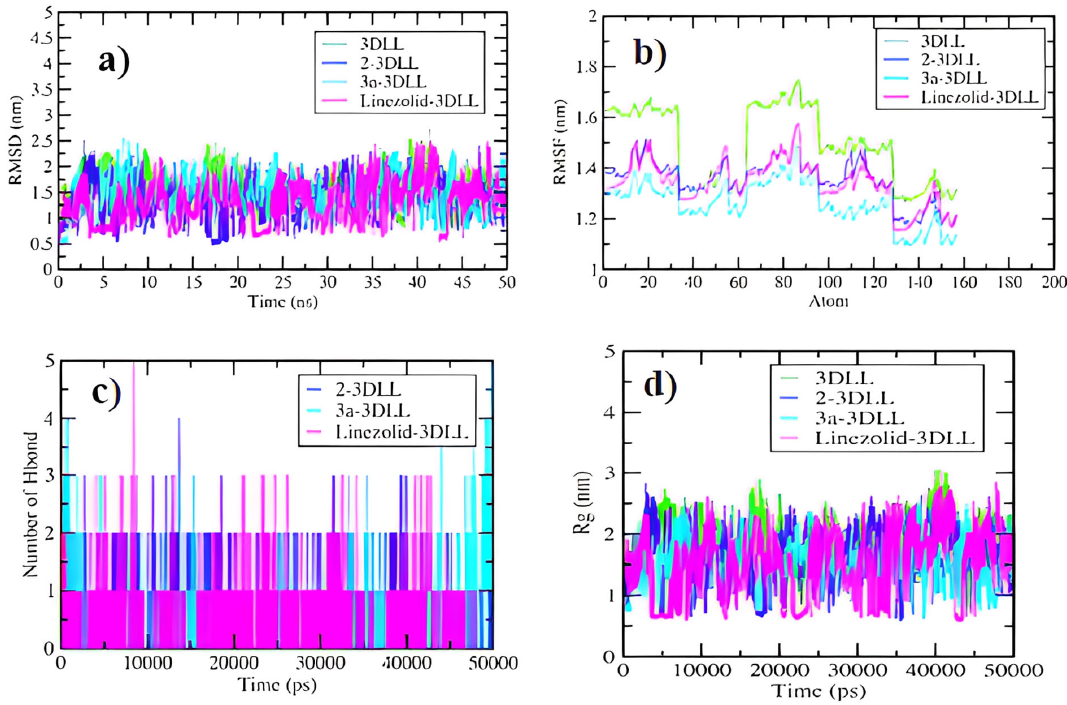
Figure 4. 2D plots obtained in the MDS study. ( a ) RMSD plot of 3DLL in water (green), 2 -3DLL (blue), 3a -3DLL (turquois) and linezolid-3DLL (pink) complexes. ( b ) RMSF plot showing the fluctuations per residue. ( c ) Hydrogen bond plot representing the number of hydrogen bond formations. ( d ) Radius of gyration (Rg) plot representing compactness of the complexes.